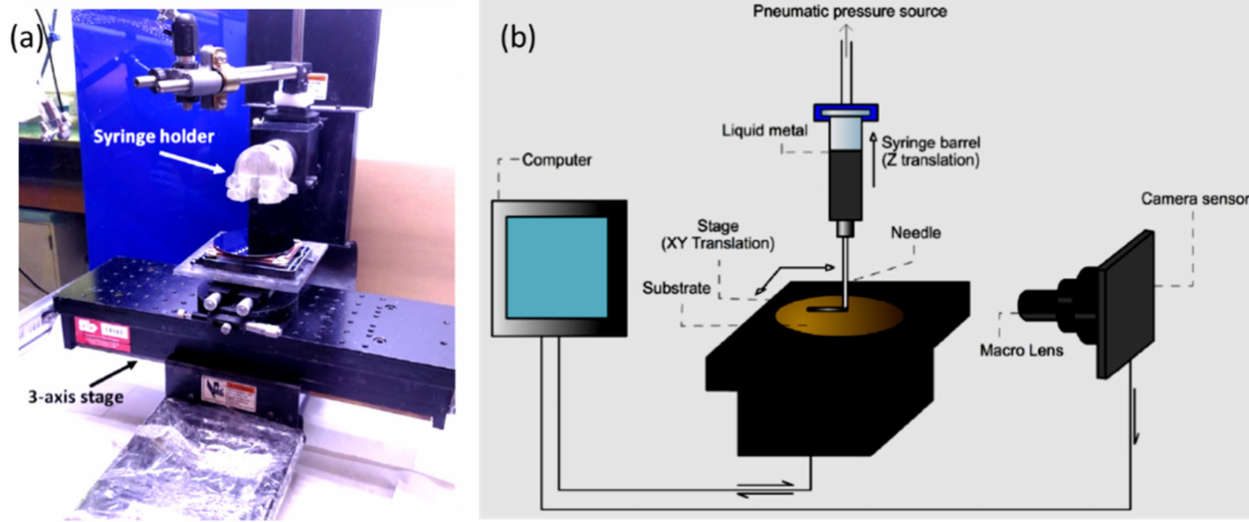
Figure 4. ( a ) Digital photograph exhibiting the custom print stage for direct printing of liquid metal contacts (left) and ( b ) a diagram to explain the 3D printing operation. Reprinted with permission from ref. [47] Copyright (2018) American Chemical